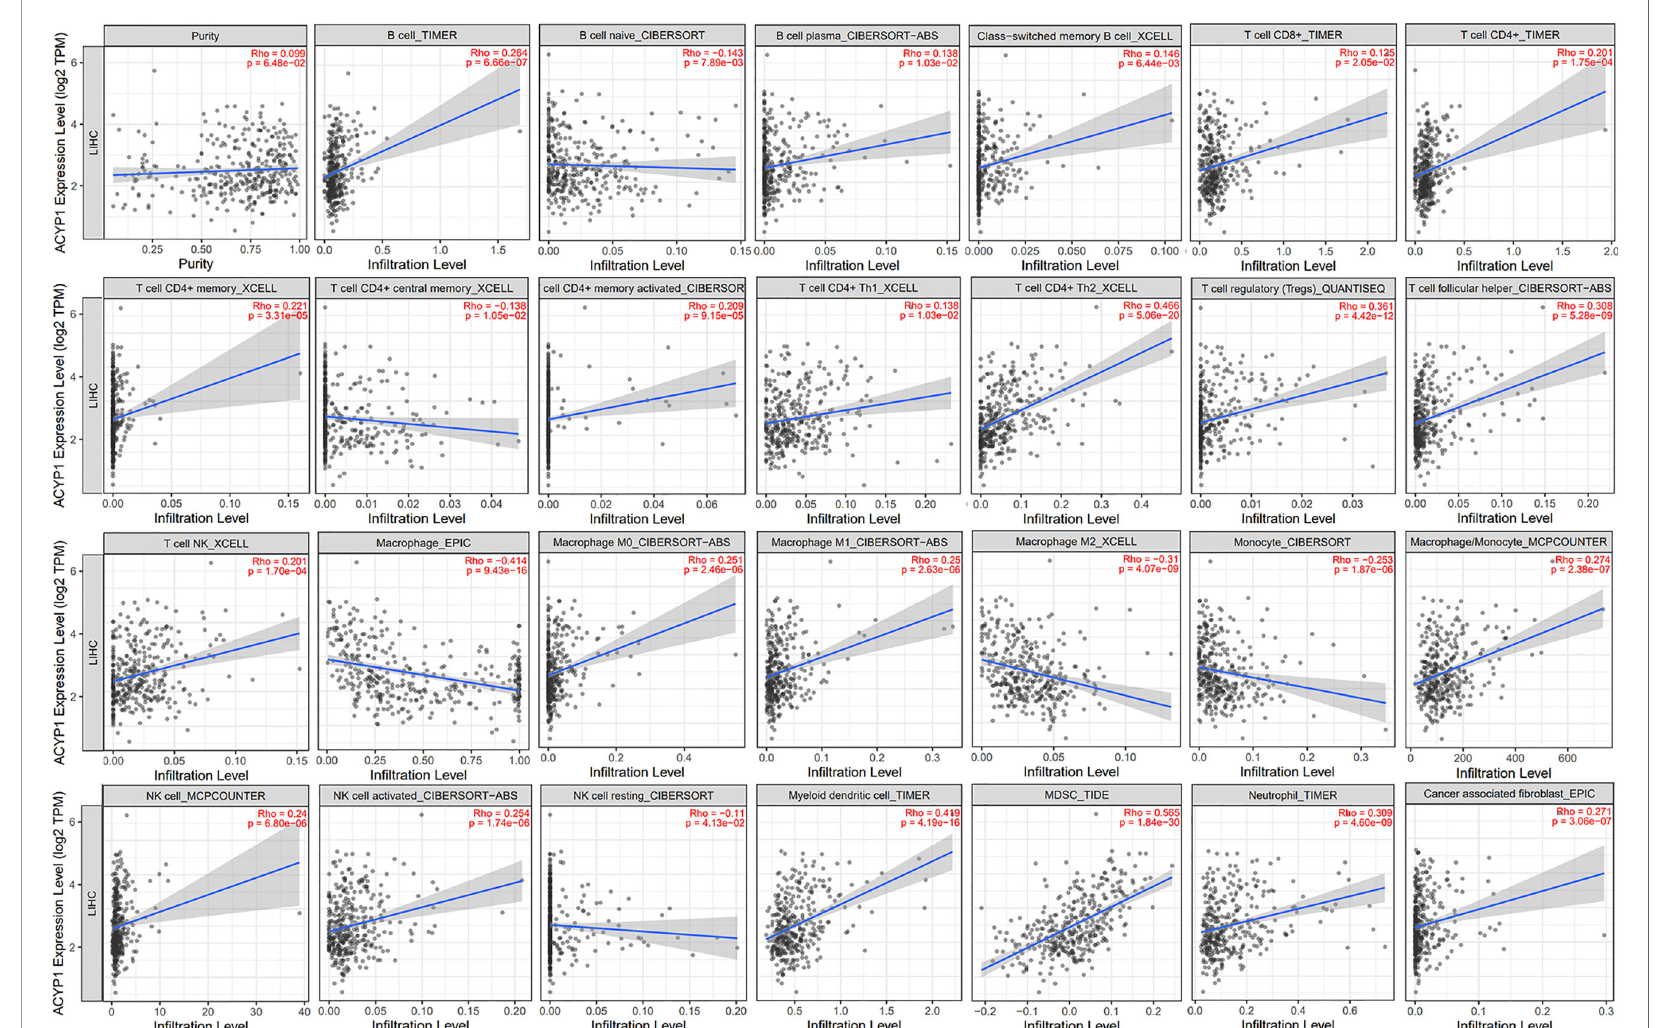
FIGURE 5 | Effects of ACYP1 expression on the TME in LIHC by using TIMER. ACYP1 expression had a signi fi cant correlation with the in fi ltration of various immune cells, including B cells, CD8+ T cells, CD4+ T cells, Tregs, Tfh cells, macrophages, monocytes, macrophages/monocytes, NK cells, DCs, MDSCs, neutrophils, cancer-associated fi broblasts, and their respective subtypes. LIHC, liver hepatocellular